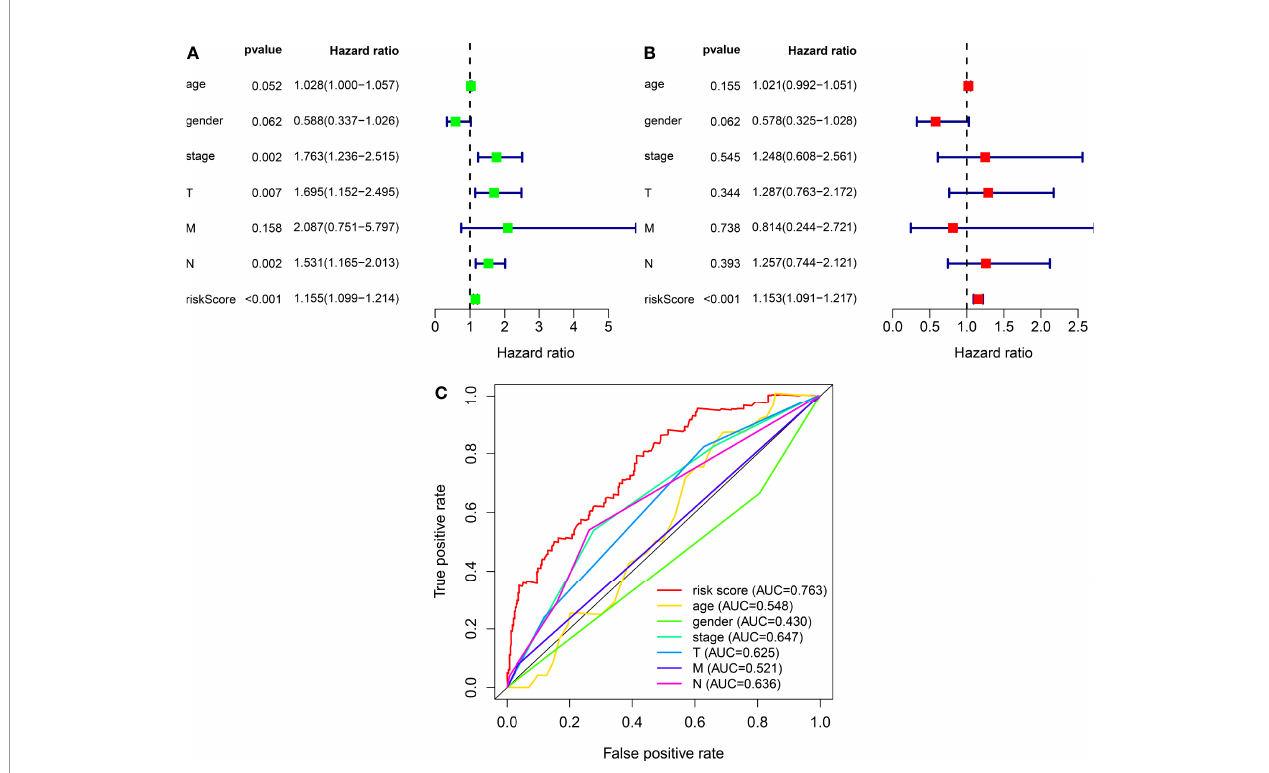
FIGURE 6 | The independence of prognostic models and clinicopathological characteristics for BLCA outcome prediction. (A) A forest map of univariate Cox regression analysis of BLCA prognostic associations. (B) A forest map of multivariate Cox regression analysis of BLCA prognostic associations. (C) Comparison of AUC values for clinicopathological characteristics and risk